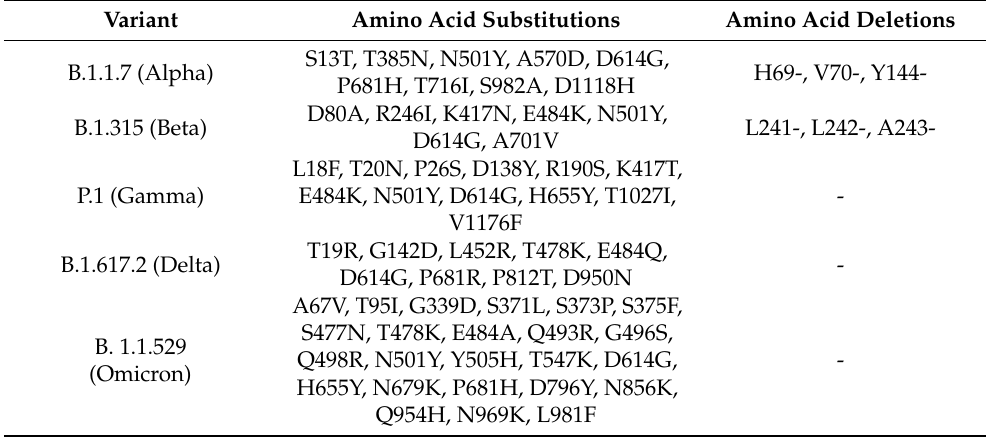
Table 2. Amino acid substitutions and deletions in spike glycoprotein from SARS-CoV-2 variants.